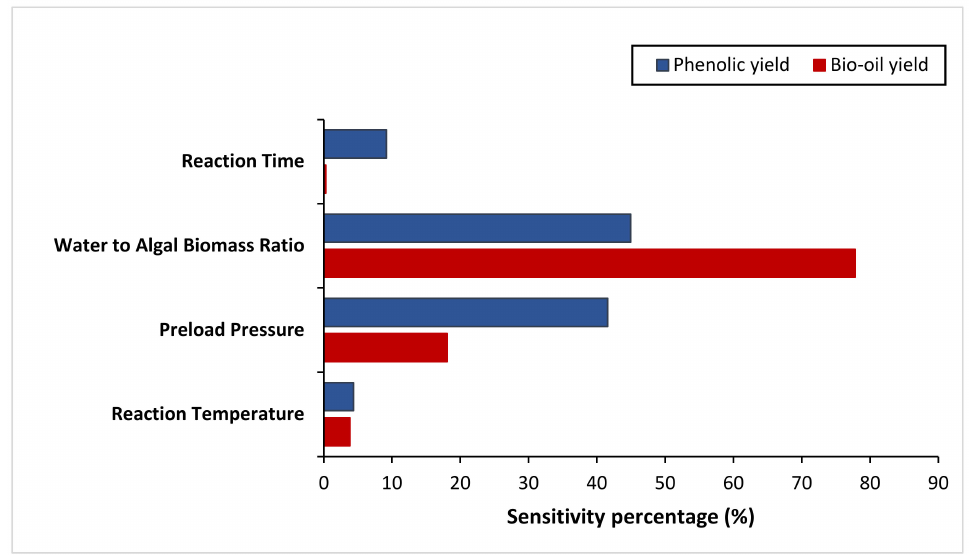
Figure 5. Results of sensitivity analysis.